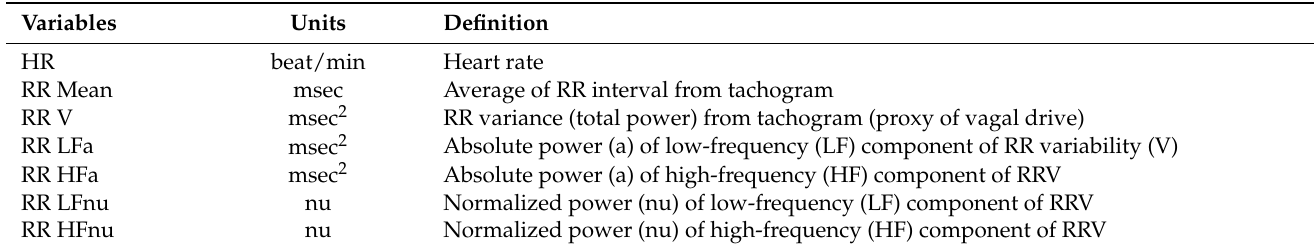
Table 1. Definitions of the variables (ANS proxies) employed in the